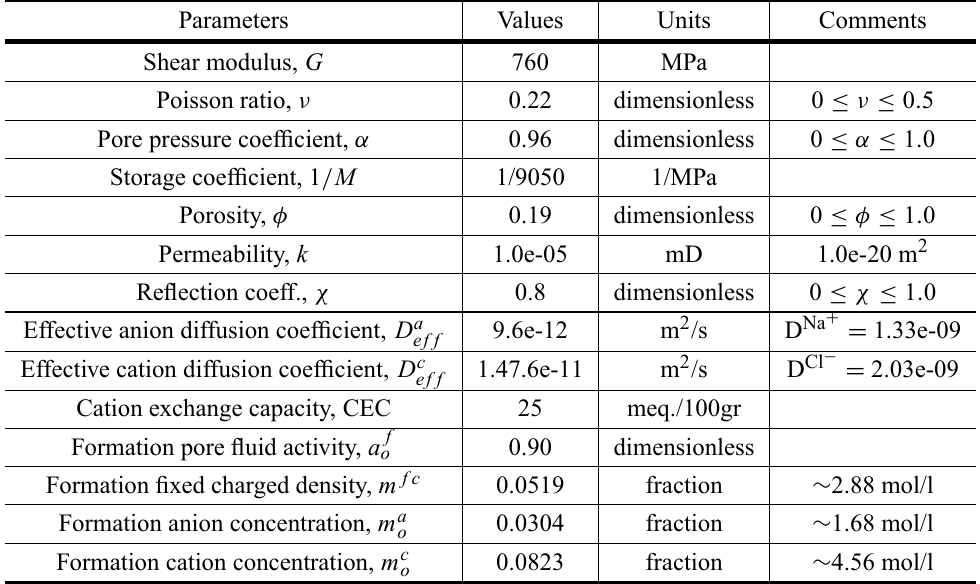
Modeling parameters for inclined